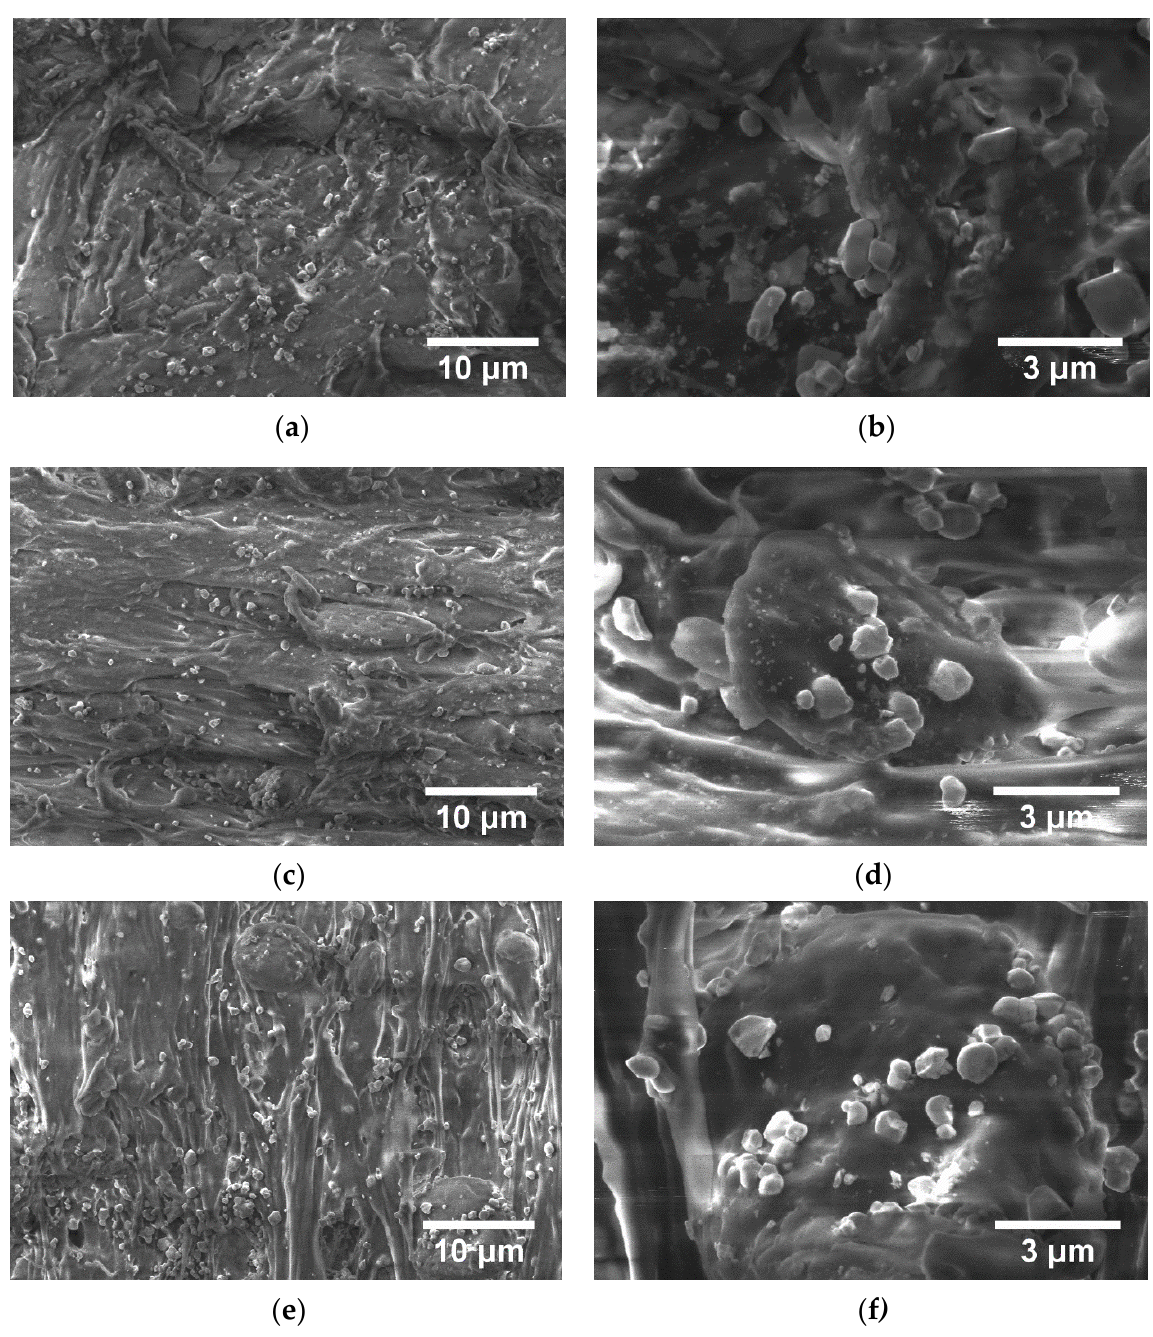
Figure 16. SEM images for composite material M4 at magnifications 5.000 × ( a ), 20.000 × ( b ), M5 at magnifications 5.000 × ( c ), 20.000 × ( d ), M6 at magnifications 5.000 × ( e ), 20.000 × ( f ).